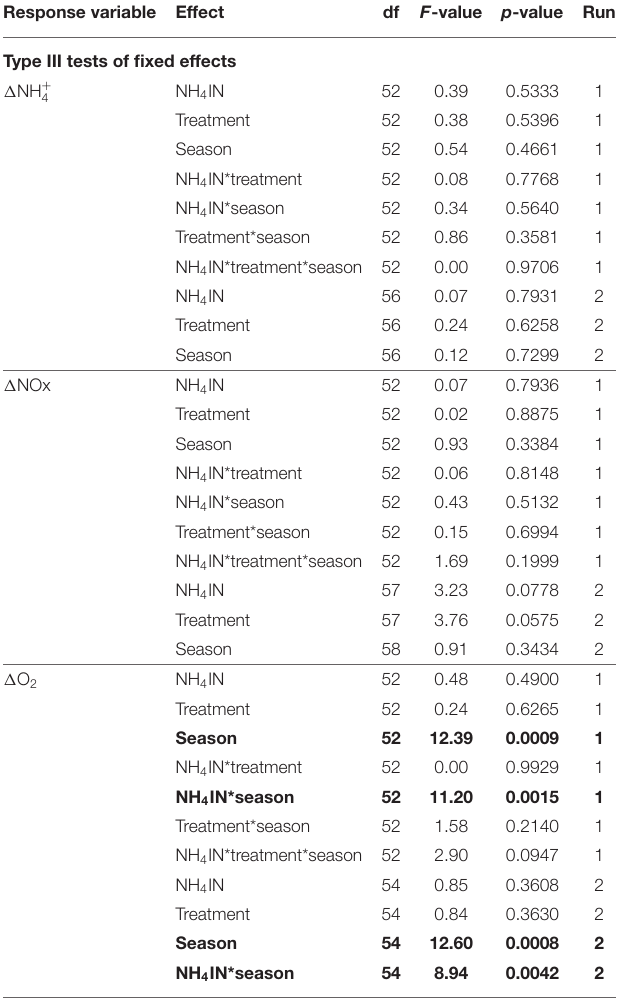
TABLE 1 | Results of GLIMMIX analysis of the effects of inhaled ammonium, treatment, and season on the outcomes of nitrification. Response variable Effect